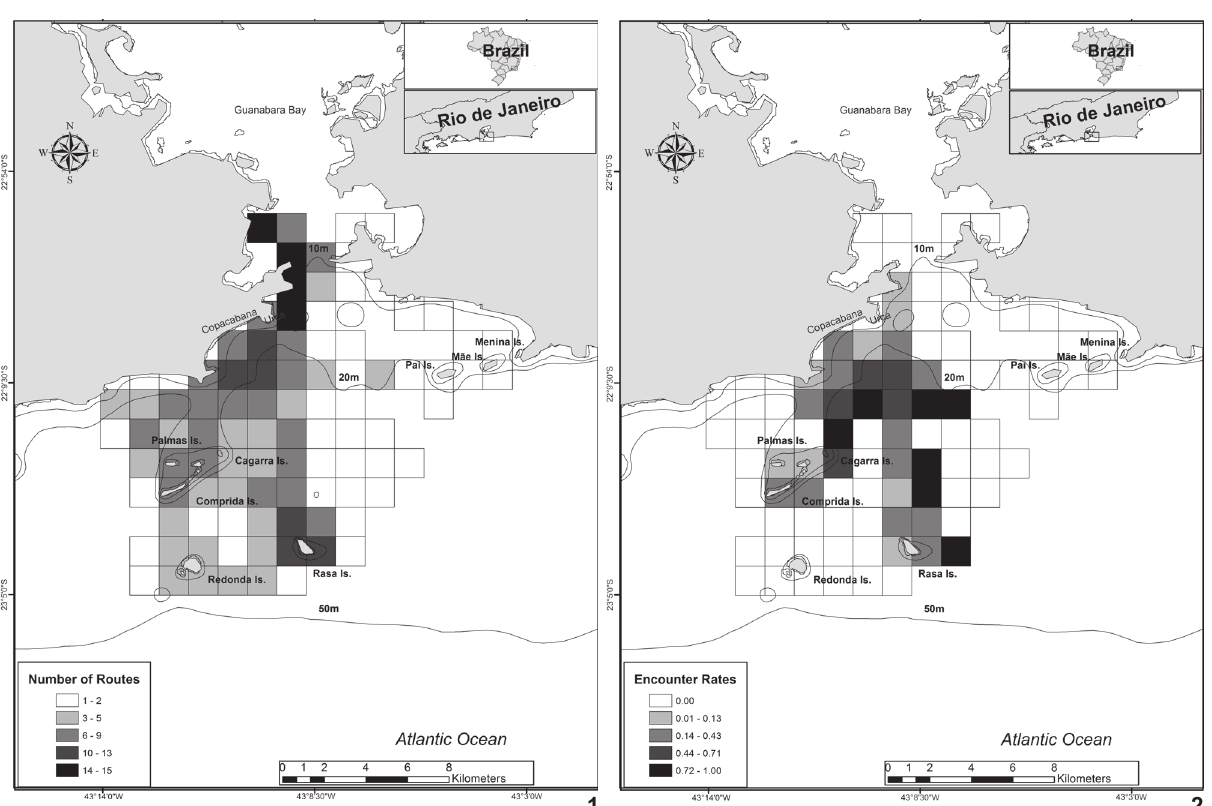
1 2 Figures 1-2. (1) Study area is delimitated by 2 x 2 km 2 grids and shows the number of routes. (2) Bryde’s whale, Balaenoptera edeni , encounter rates in the coastal waters off Rio de Janeiro, southeastern Brazil. Continuous lines indicate bathymetric stripes.